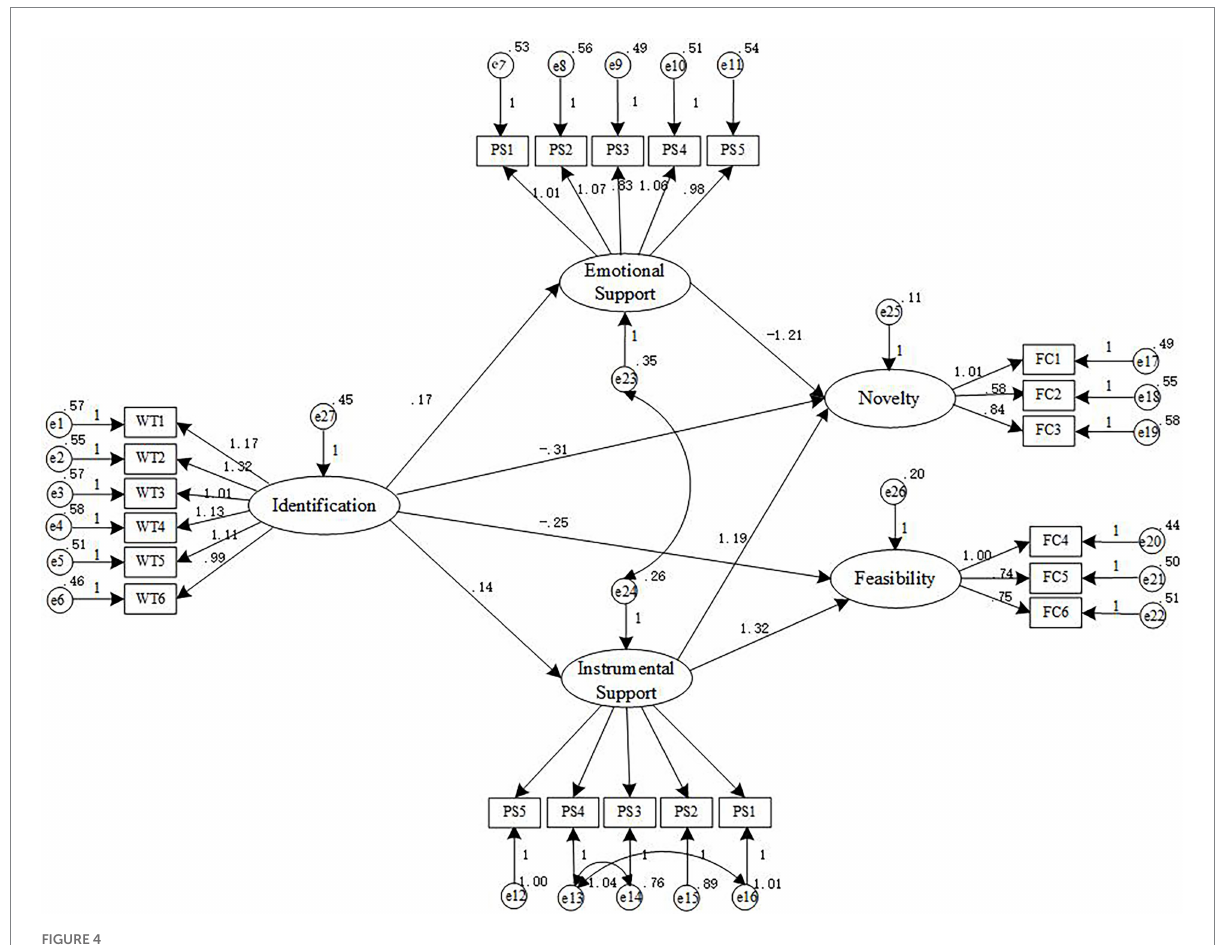
FIGURE 4 Mediating role model (after revision).